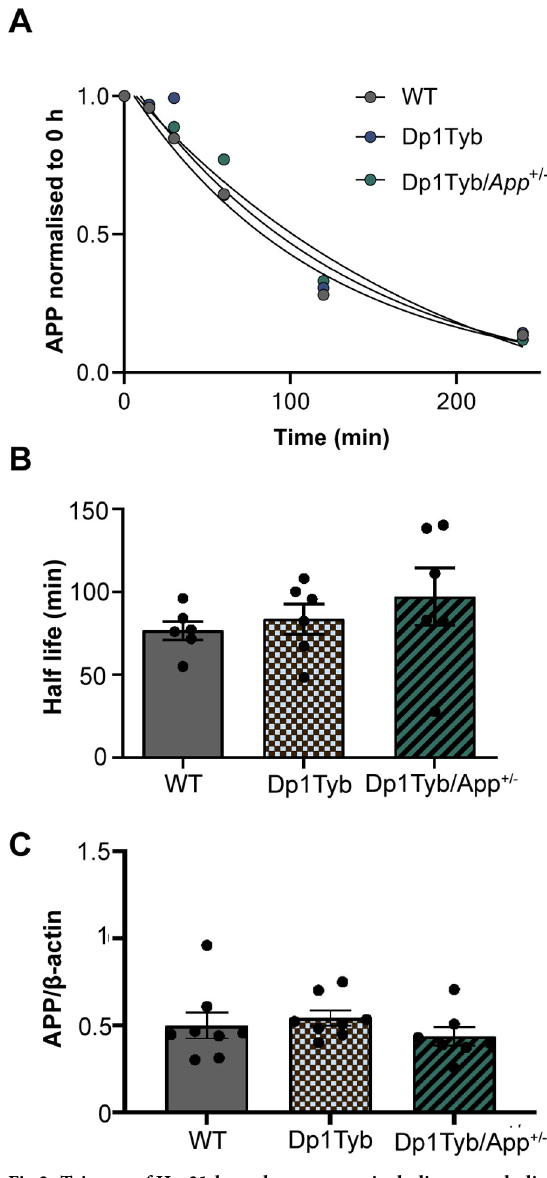
Fig 2. Trisomy of Hsa21-homologous genes including or excluding App does not affect APP half-life in MEFs. A) Degradation curve of APP in Dp1Tyb, Dp1Tyb/ App +/ - and WT MEFs. B) Half-life of APP is not significantly different in Dp1Tyb, Dp1Tyb/ App +/ - and WT MEFs (One-way ANOVA, p = 0.48, N = 5/6). Average APP half-life in minutes: Dp1Tyb = 84 ± 9; Dp1Tyb/ App +/- = 97 ± 17; WT = 77 ± 6). C) APP abundance is not significantly different in Dp1Tyb, Dp1Tyb/ App +/ - and WT MEFs (One-way ANOVA, p = 0.77, N = 6). Average APP/ β -actin: Dp1Tyb = 0.93 ± 0.07; Dp1Tyb/ App +/- = 0.83 ± 0.1; WT = 0.93 ± 0.15). Each dot corresponds to a biological repeat (i.e. an independent MEF line used). For each biological repeat, three technical repeats (i.e. western blot) were performed. Error bars = SEM. All full uncropped western blots are available at Figshare